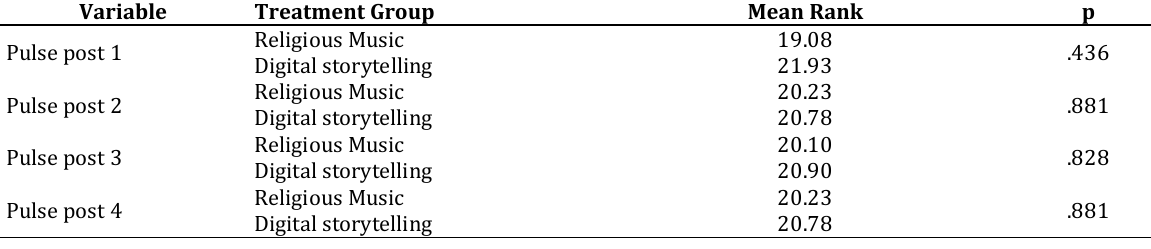
Table 7 Mann Whitney Test Results The Effectiveness of Religious Music and Digital Storytelling on a Child's Pulse